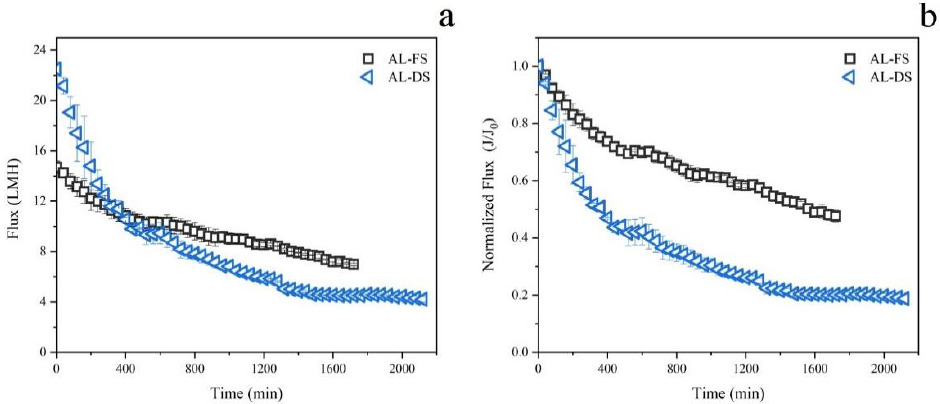
Figure 2. The variation of water flux at AL-FS and AL-DS membrane orientations. ( a ) the absolute value of water flux, ( b ) the normalized water flux. All the data points were determined three times, and their mean values and standard deviation were given.